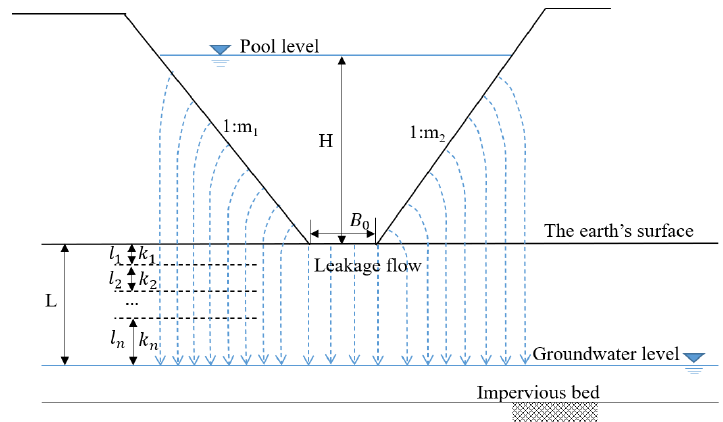
Figure 7. Groundwater level close to earth surface.